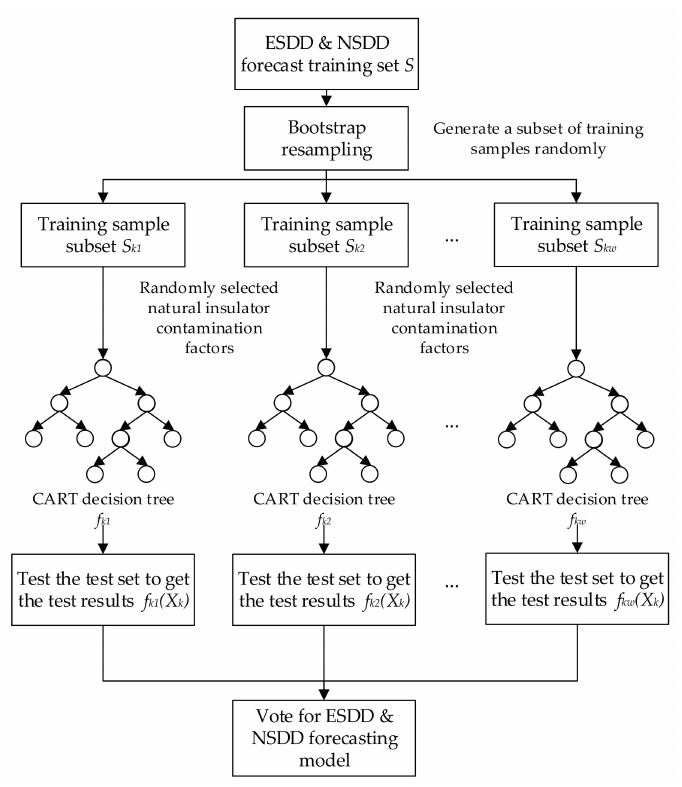
Figure 2. Modelling process of ESDD and NSDD forecasting based on